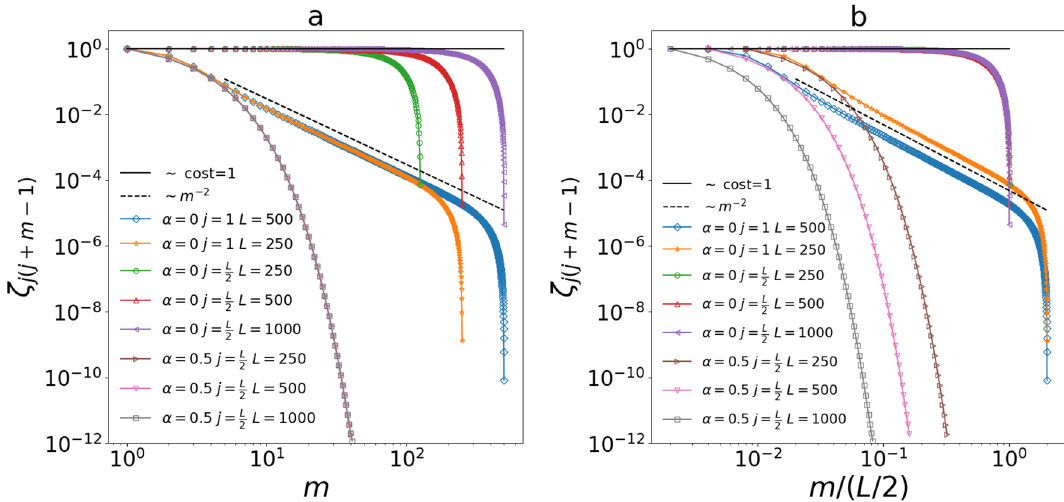
1, L 0.001 and 2 , T 1 β T a T L 2 for = = = = = 1 and diagonalising A . s ˆ = ≫